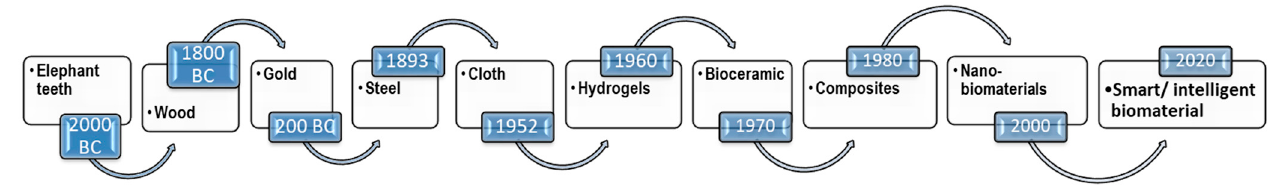
Figure 2. Evolution of biomaterials from ancient prosthetics such as elephant teeth to nano-biomaterials and smart/intelligent biomaterials used in the present era.